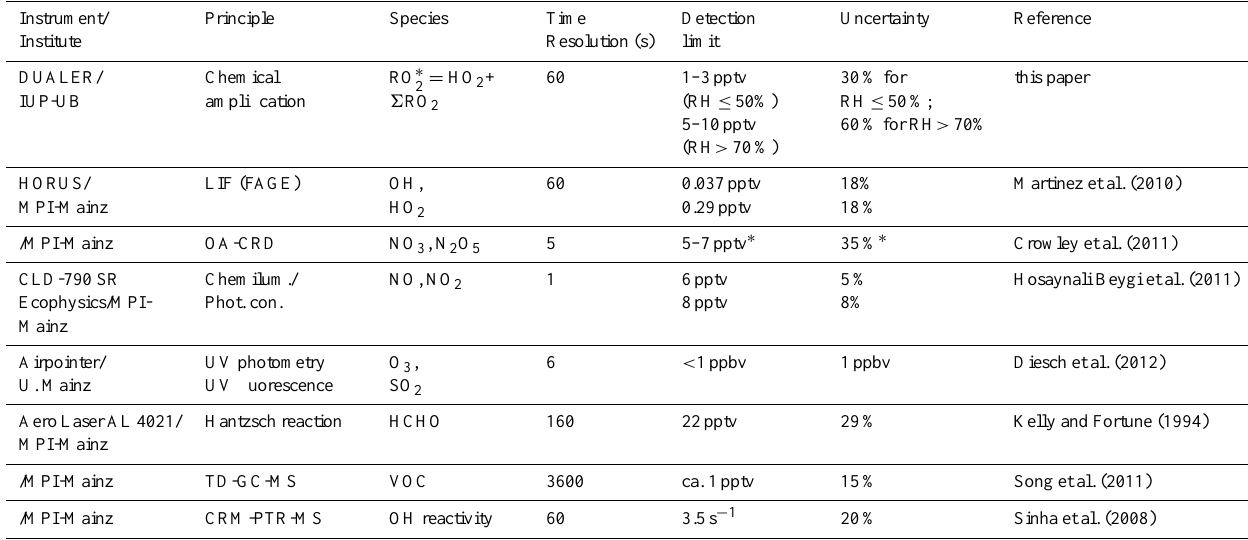
Table 1. Main features of the DOMINO instruments used in this study. IUP-UB: Institute for Environmental Physics of the University of Bremen; MPI: Max Planck Institute; U. Mainz: University of Mainz; LIF (FAGE): Laser Induced Fluorescence (Fluorescence Assay with Gas Expansion); OA-CRD: Off Axis Cavity Ring Down; Chemilum./Phot. con.: Chemiluminiscence/Photolytical conversion; TD-GC-MS: